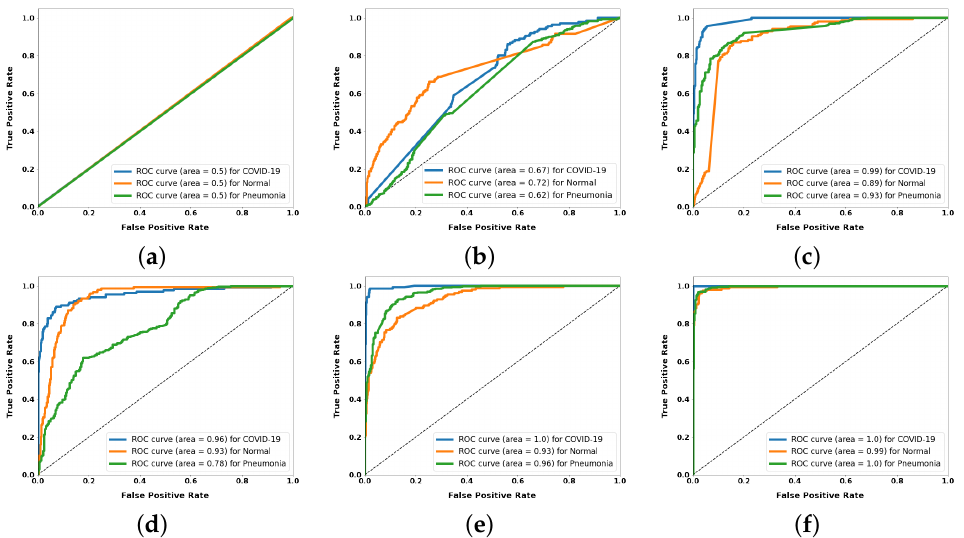
Figure 10. ROC curves of the pre-trained models with learning rate η = 0.1, ReLU activation function, and Adam optimizer. ( a ) VGG16, ( b ) Xception, ( c ) DenseNet121, ( d ) InceptionV3, ( e ) ResNet50, and ( f )